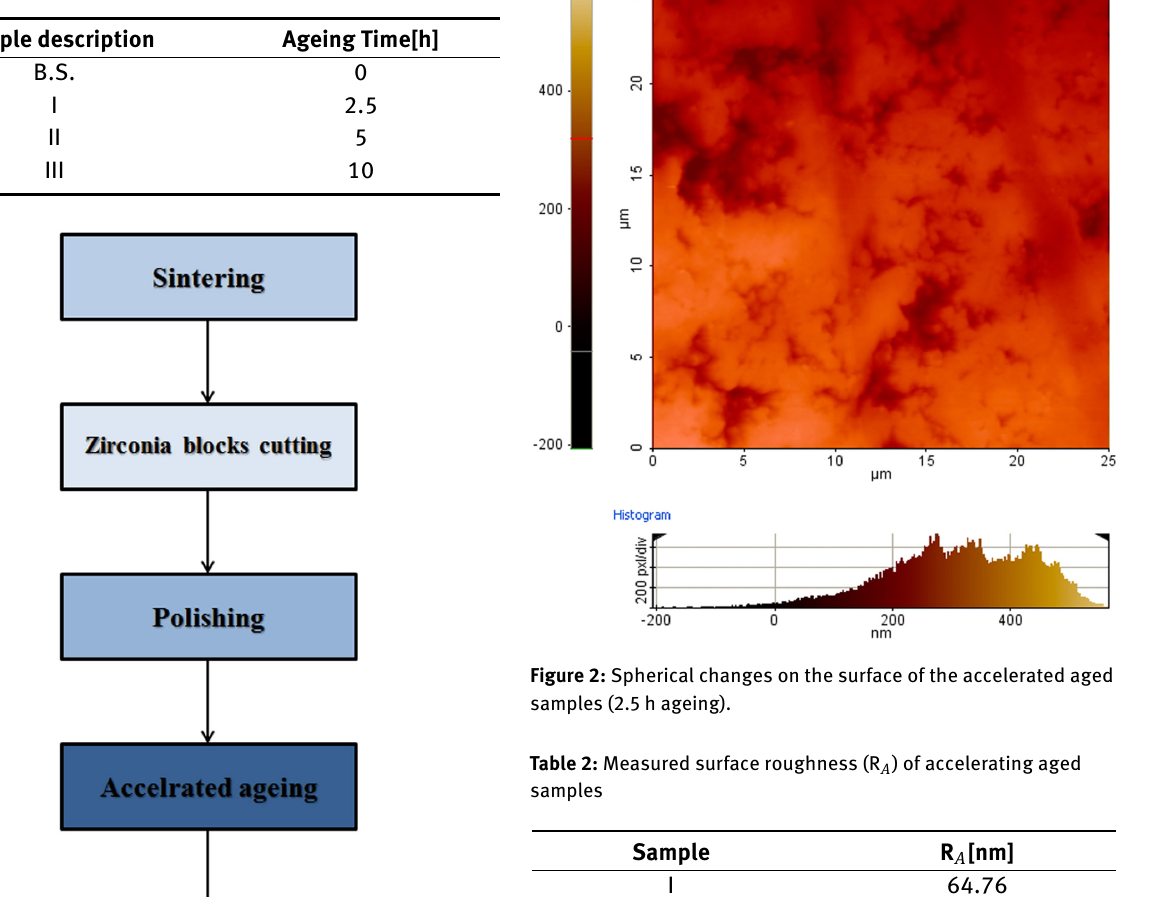
Table 1: Sample description